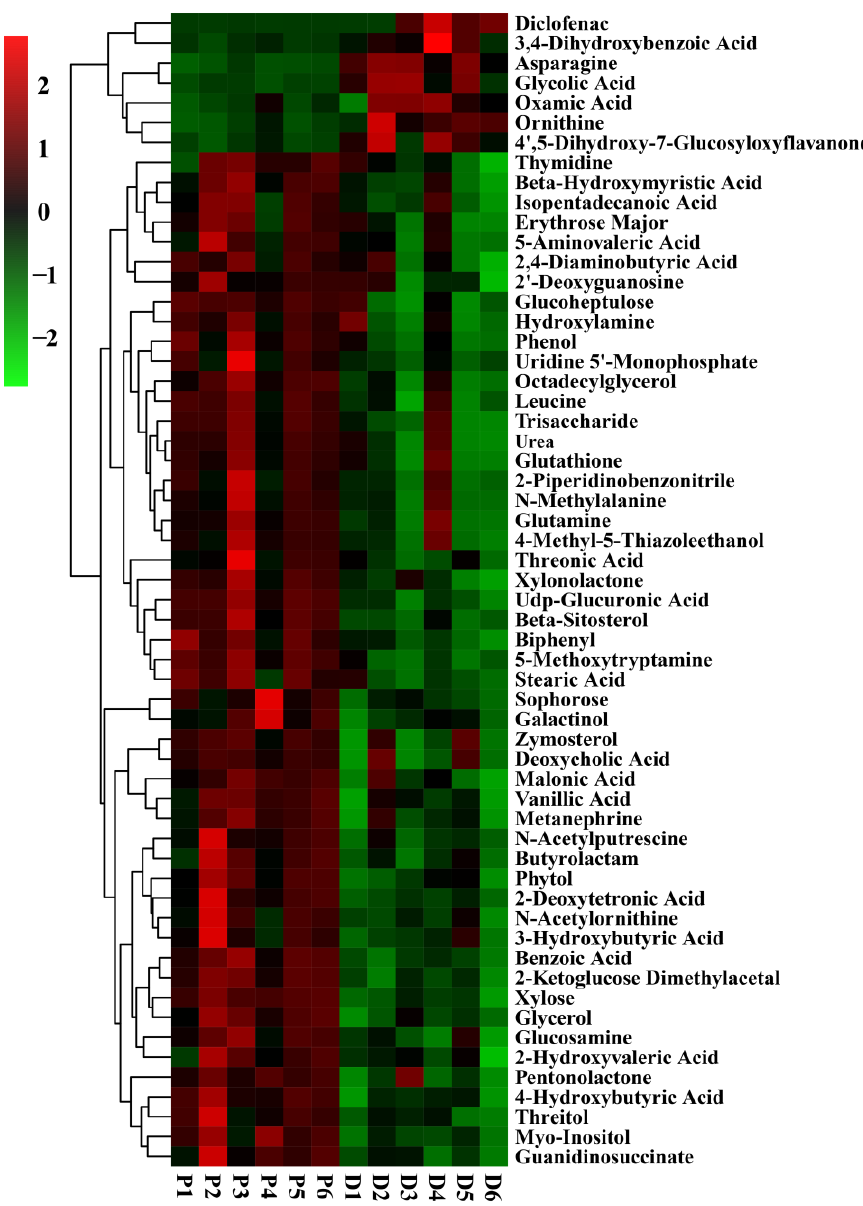
Figure 6. Thermogram analysis of metabolites in the rhizosphere soils of bayberry. D and P represent trees with decline diseased and disease in combination with the fungicide prochloraz, respectively.